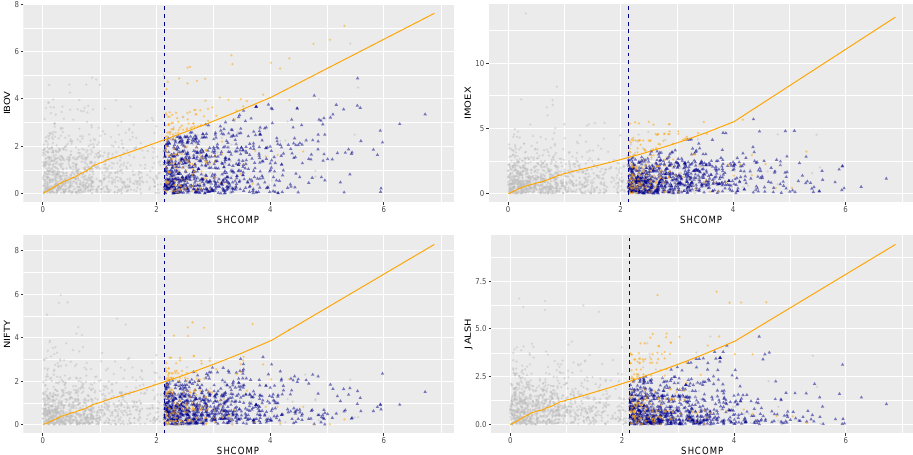
Figure 10. Prediction plot conditioning on SHCOMP being above its 90th